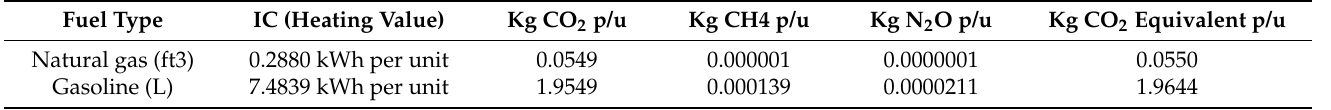
Table A4. Heating values of the different fuels used for